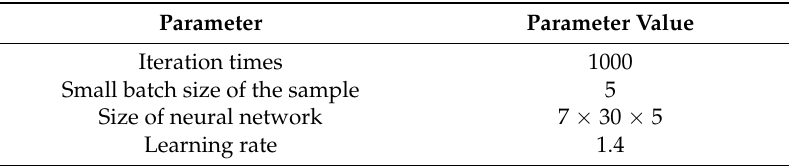
Table 7. Neural network model initialization